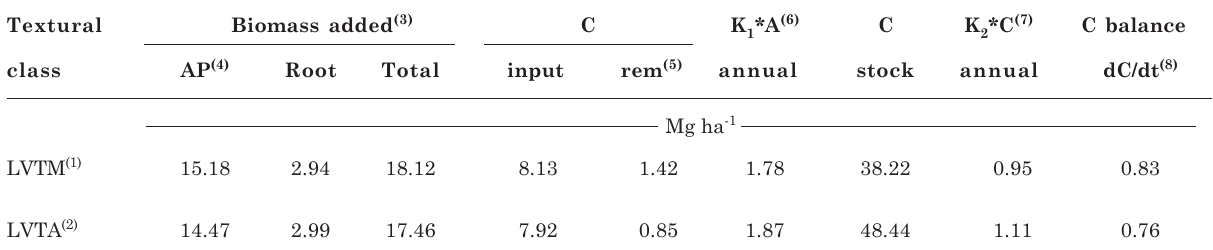
Table 5. Carbon balance in Typic Hapludox (Oxisol) with medium texture (LVTM) and clay texture (LVTA) for the 0-20 cm layer, based on the unicompartmental model proposed by Hénin & Dupuis